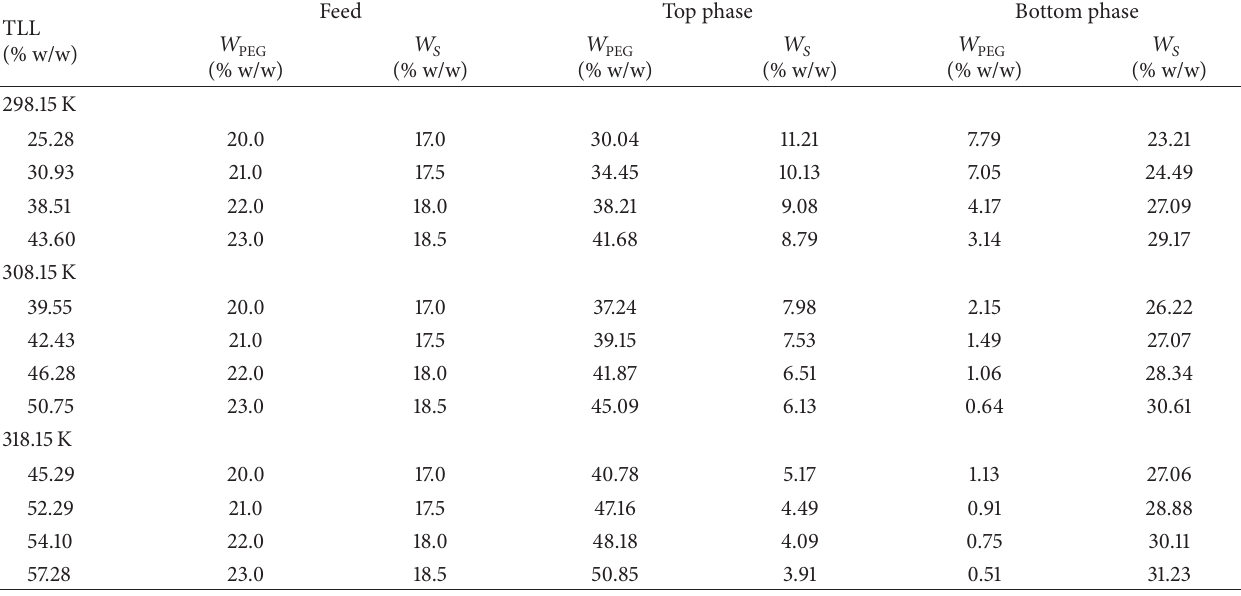
Table 5: Tie-line composition for the PEG 6000 + sodium succinate + water system at different temperatures. Top phase Bottom phase